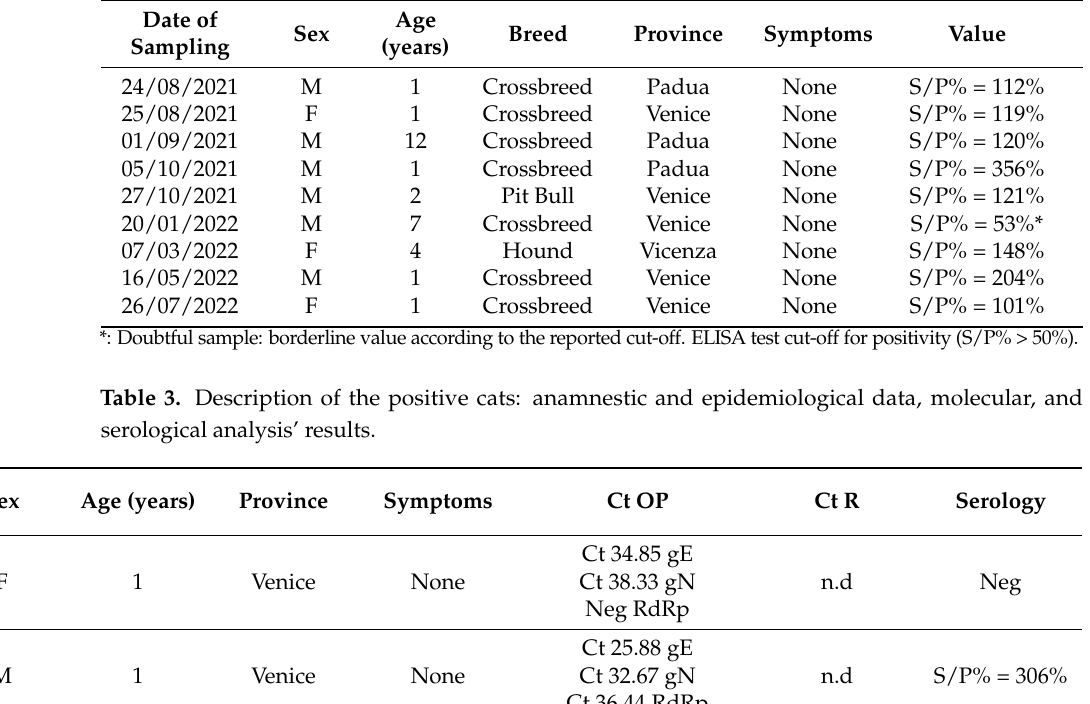
Table 2. Epidemiological and anamnestic details of seropositive dogs. Results SARS-CoV-2 ELISA-test (S/P% values).